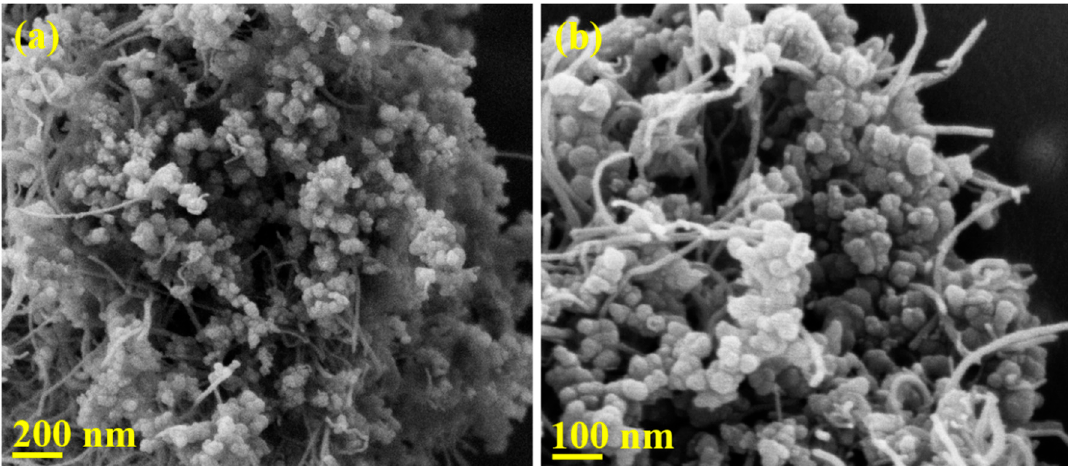
Figure 3. ( a , b ) FE-SEM images of the MWCNTs/AC/BNNTs ternary composite material at different magnifications.